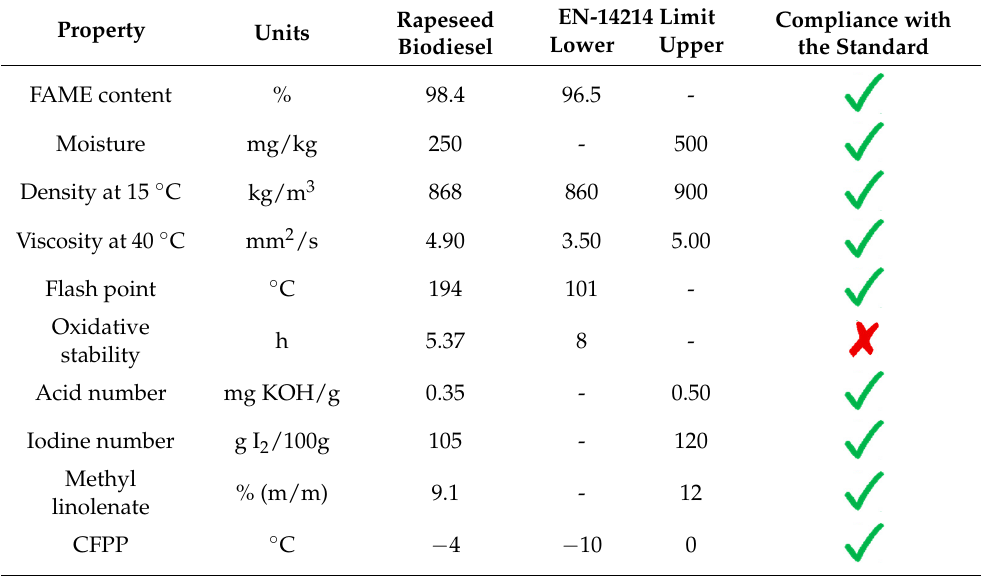
Table 2. Main features of rapeseed biodiesel and comparison with the standard (green tick = compliance; wrong red cross = non-compliance).